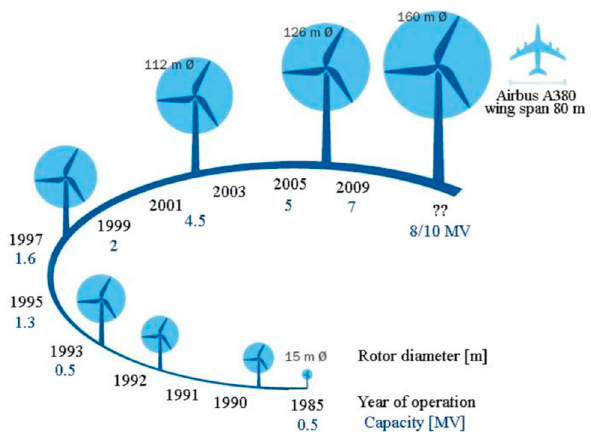
Figure 1. Size evolution of wind turbine blades [2].